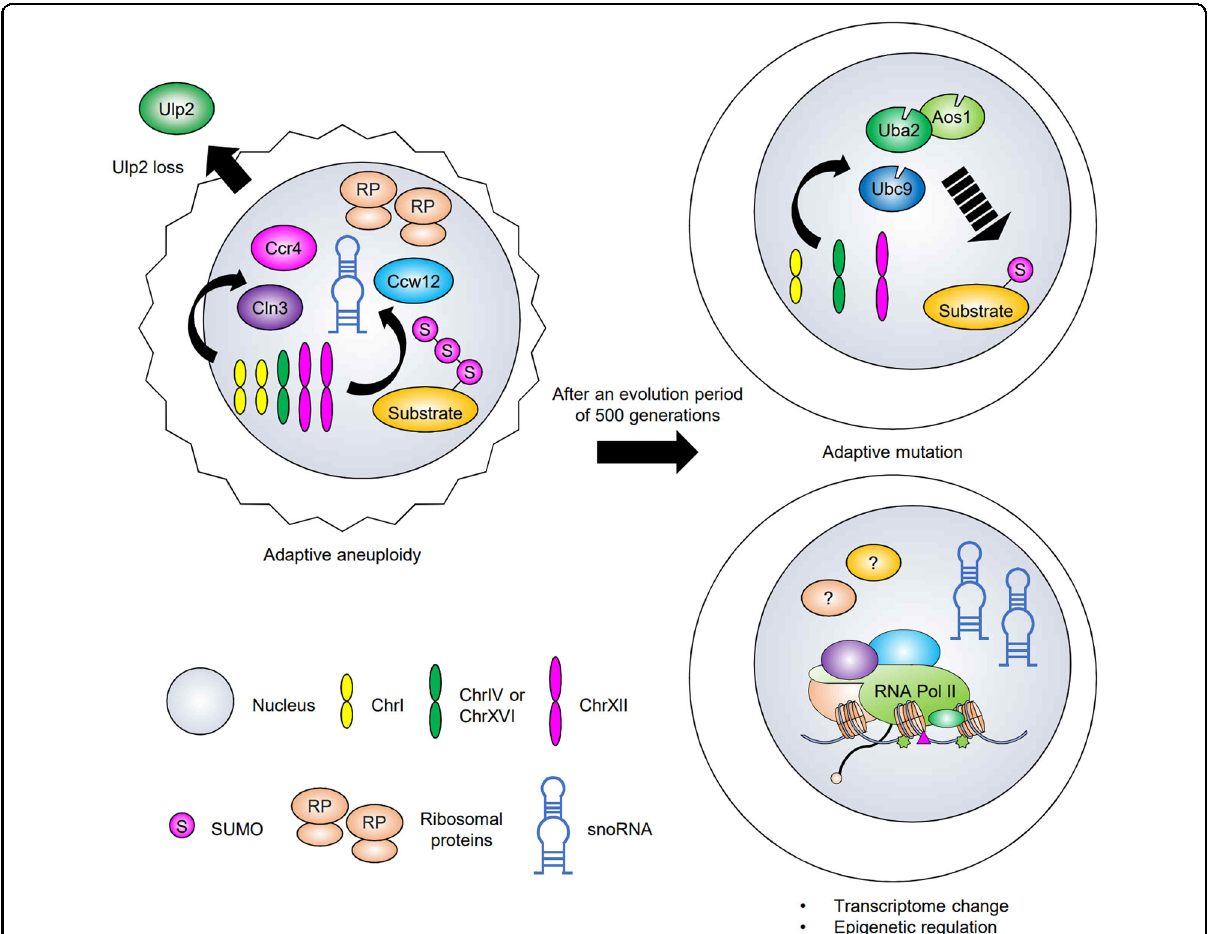
Fig. 2 Evolution of adaptive mechanisms upon the loss of Ulp2. The loss of Ulp2 in yeast leads to the accumulation of polySUMO-conjugated proteins, increased expression of ribosomal proteins and reduced cell fi tness (depicted by the irregular cell outline). Disomies of ChrI and ChrXII provide a transient adaptive solution by virtue of an increased dosage of three protein-coding genes, CCR4 , CLN3 , and CCW12 , and a snoRNA gene cluster consisting of SNR61 , SNR55 , and SNR57 . Following evolution over many cell generations, disomies of both ChrI and XII are replaced with two other adaptive mechanisms: mutations of SUMO-ligating enzymes and speci fi c transcriptome changes. Point mutations in UBC9 or UBA2 , on ChrIV, or AOS1 , on ChrXVI, reduce SUMO conjugation and suppress the growth defects of ulp2 Δ cells. In parallel, the upregulation of numerous snoRNA genes, which can repress the transcription of RP genes, and re fi ned transcriptome alterations concomitant with epigenetic changes (unpublished data) appear to facilitate further